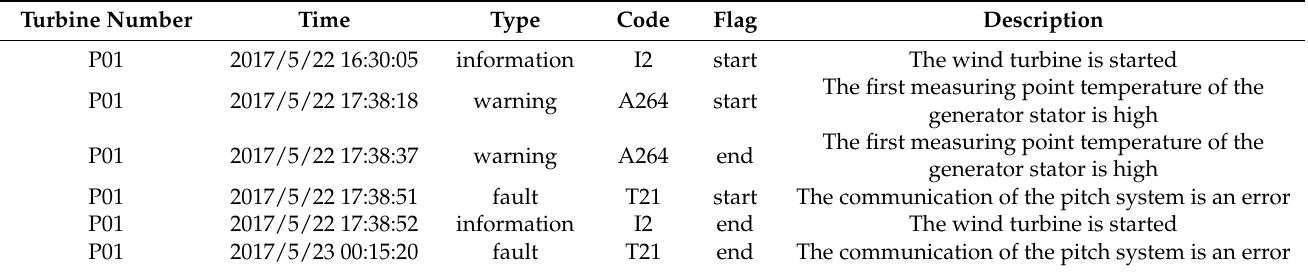
Table 1. A list of SCADA alarms.